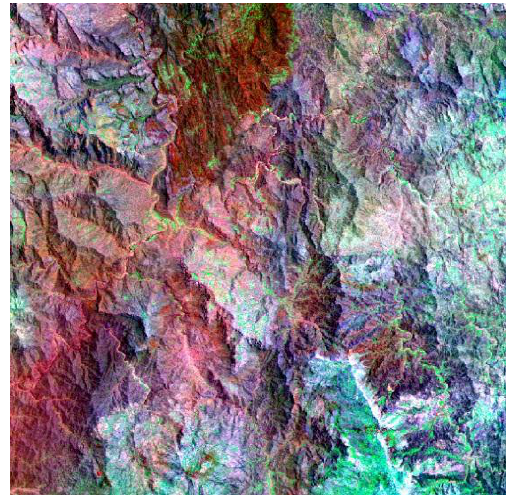
Fig 6. Band Ratio (7/5, 6/4, 4/2) Combination MNF colour composite bands (7,5,1). These were used as a reference for the manual extracted lineament. Band ratios (7/5, 6/4, 4/2) it’s suitable for distinguished clearly between the rocks unites. Landsat 8_OLI satellite data were used band 1 to 7 likes layer stacking and resolution merge it with band 8 was found as